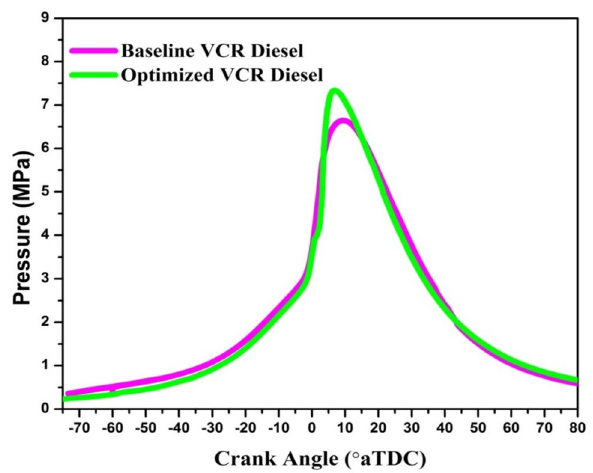
Fig. 8 Comparison of NOx versus Crank Angle for optimized and baseline (VCR diesel)